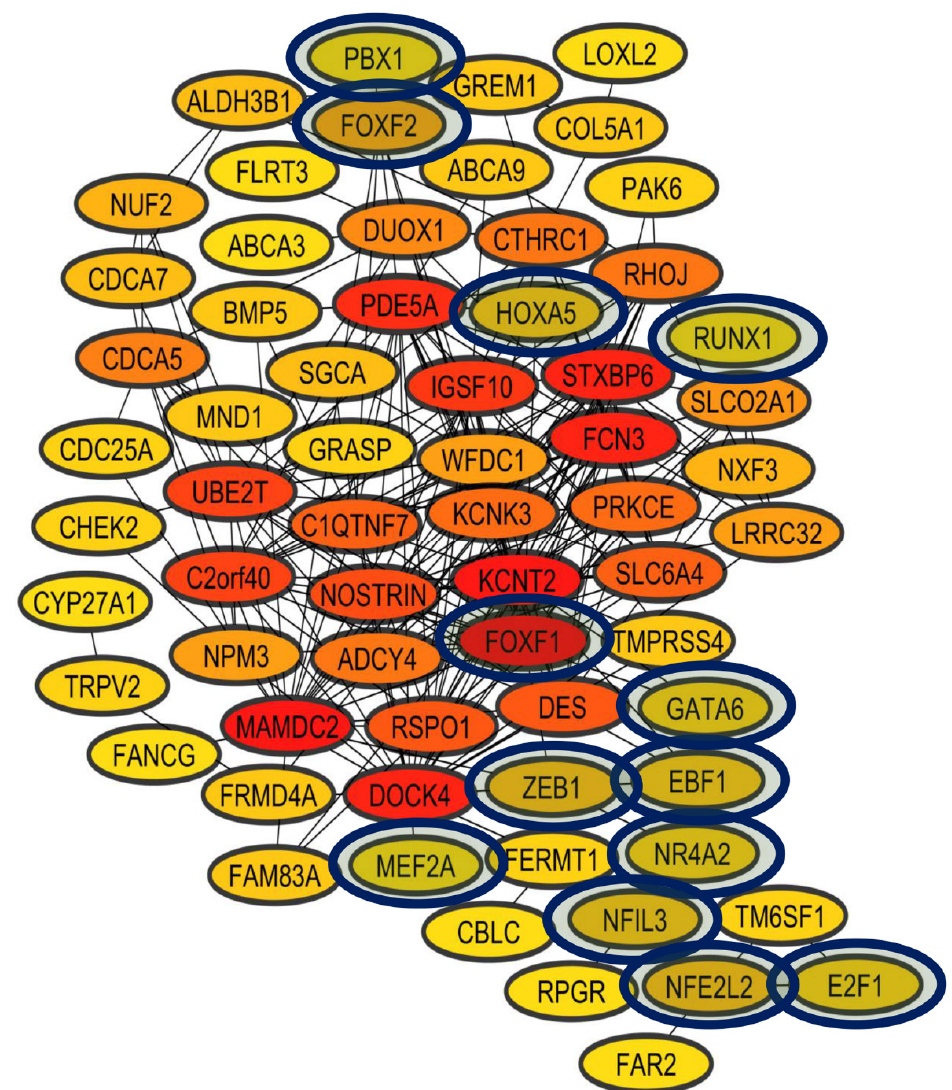
Figure 9. Coexpression network of unique lung cancer winning deregulated genes that are not deregulated in other types of cancer (LCII coexpression network). In red are the most connected nodes, in orange the average connected nodes, and in yellow the less connected nodes. The TFs are highlighted inside the blue ovals.